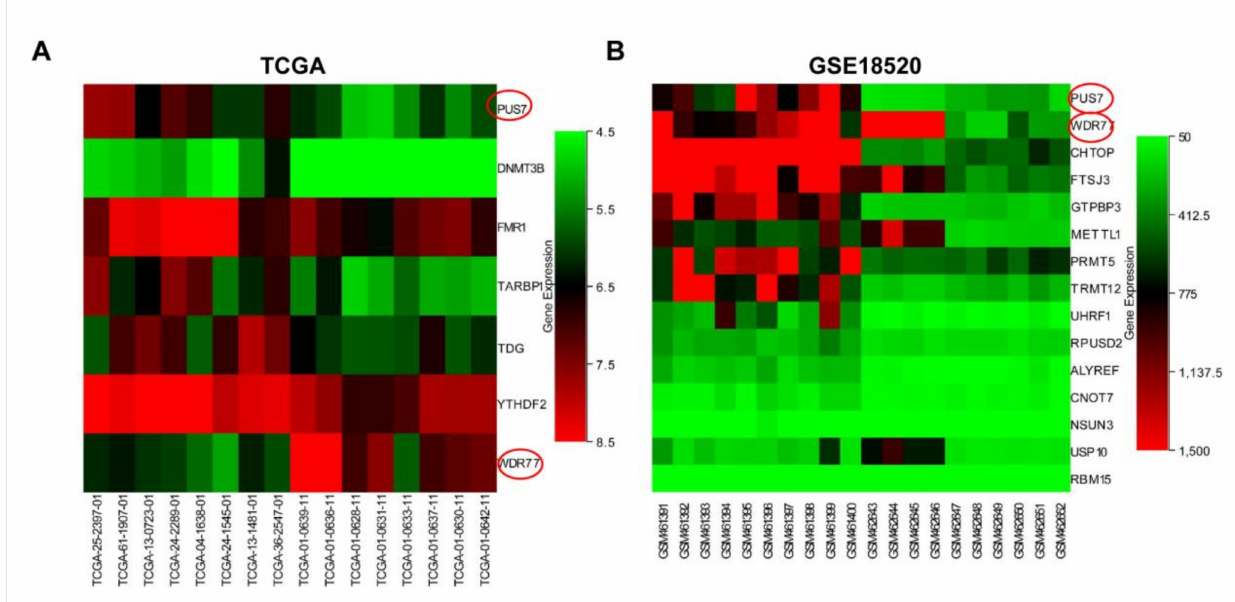
Figure 1. The identification of DEGs-RMGs using OV data in TCGA and GEO. ( A , B ) The volcano plot of DEGs between OV and normal samples in GSE18520 and TCGA data. ( C ) WDR77 and PUS7 were identified as the overlapping genes of DEGs in both datasets.